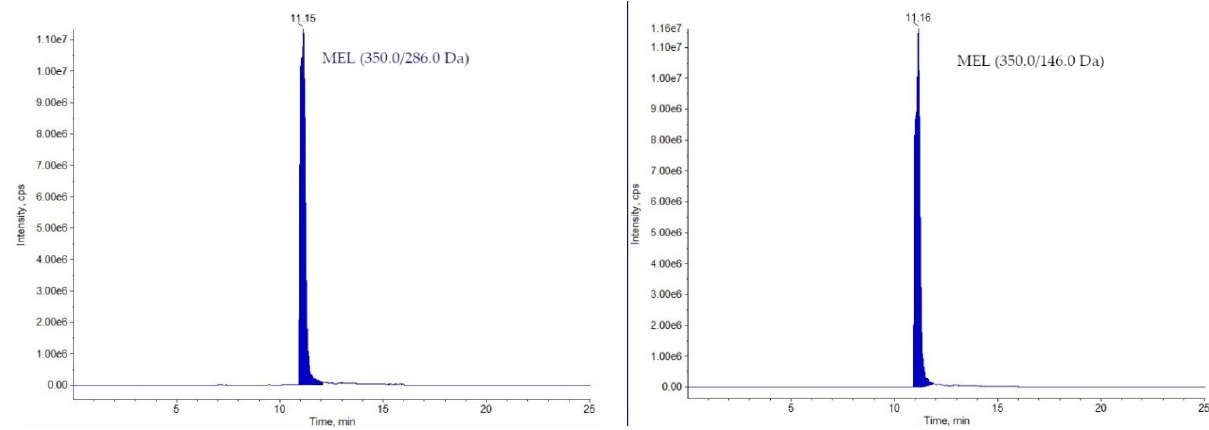
Figure 3. Chromatograms of the non-compliant muscle sample containing MEL.